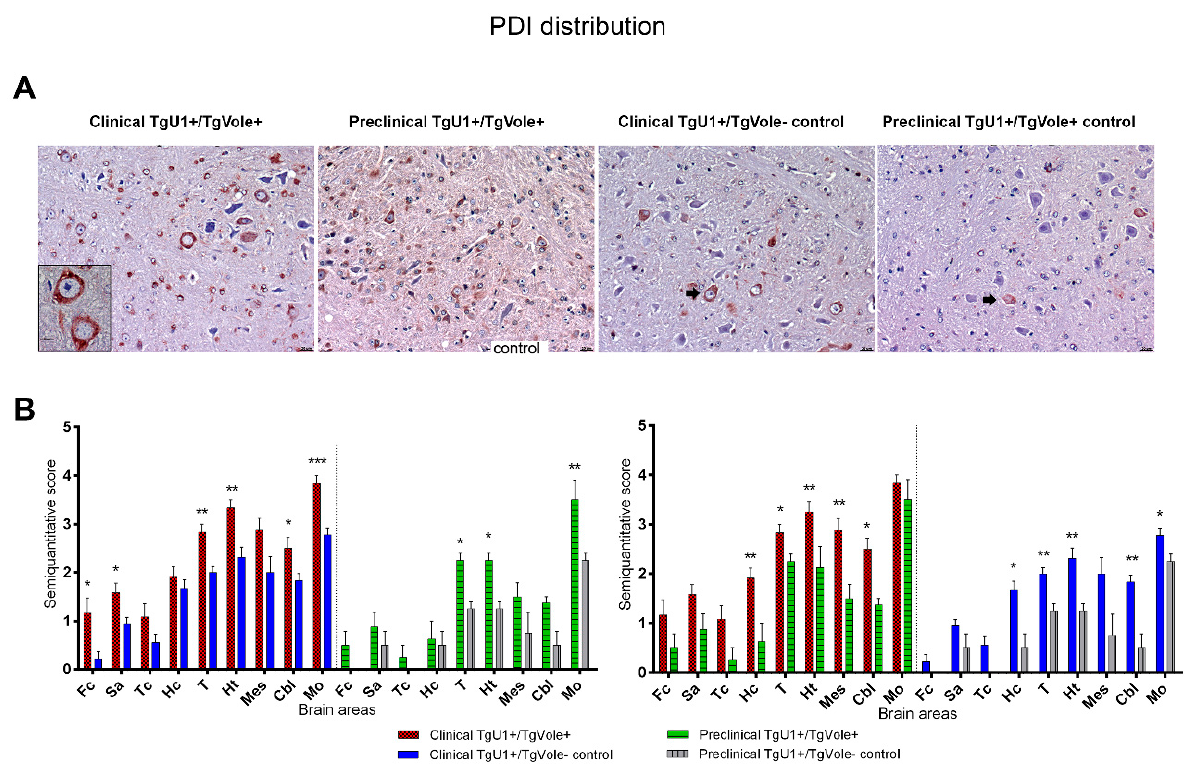
Figure 3. Protein disulfide isomerase (PDI) accumulation is more intense in clinical TgU1 + /TgVole + mice than in preclinical TgU1 + /TgVole + mice and healthy TgU1 + /TgVole − controls in all brain areas. ( A ) A strong intraneuronal PDI labeling was observed in the gigantocellular reticular nucleus of the medulla oblongata of clinical TgU1 + /TgVole + mice. Intraneuronal PDI immunolabeling was also observed in the other groups of mice, but the intensity of the immunostaining and the number of immunopositive cells were reduced compared with clinical TgU1 + /TgVole + mice (arrows). Insert picture contains two neurons showing a strong accumulation of PDI. ( B ) PDI distribution in the brains of clinical and preclinical TgU1 + /TgVole + mice and their age-matched controls. PDI immunolabeling was semiquantitatively analyzed and scored on a scale of 0 (absence of immunolabeling) to 5 (very intense immunolabeling) in nine brain areas. Each group included the following number of animals: clinical TgU1 + /TgVole + n = 6 (4 female, 2 male), clinical TgU1 + /TgVole − controls n = 8 (6 female, 2 male), preclinical TgU1 + /TgVole + n = 5 (2 female, 3 male) and preclinical TgU1 + /TgVole − controls n = 5 (2 female, 3 male). Comparison of the PDI immunolabeling profiles revealed significant differences between the group of clinical TgU1 + /TgVole + mice and clinical TgU1 + /TgVole − controls in certain brain areas and between preclinical TgU1 + /TgVole + mice and preclinical TgU1 + /TgVole − controls. Significant differences in PDI immunostaining were also noticed between clinical and preclinical TgU1 + /TgVole + mice and between clinical and preclinical TgU1 + /TgVole − controls. (* p < 0.05, ** p < 0.01, *** p < 0.001, Mann-Whitney U